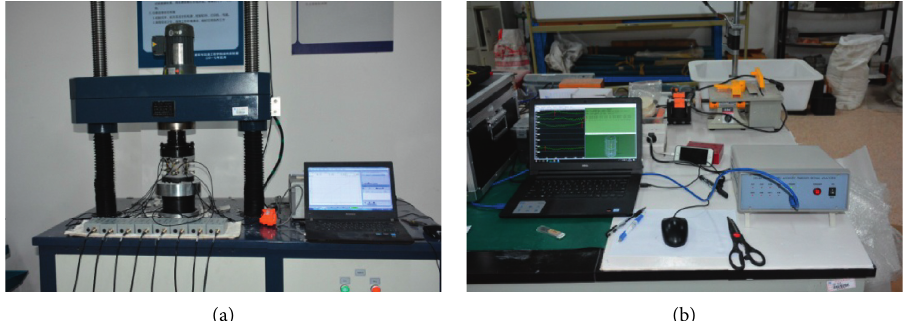
Figure 3: Physical experiment system diagram: (a) loading module and (b) acoustic emission (AE) module.